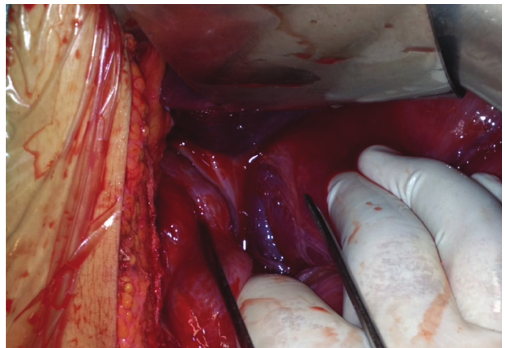
Figure 6: The approximation of the gastroesophageal junction and pylorus, leading to gastric volvulus.